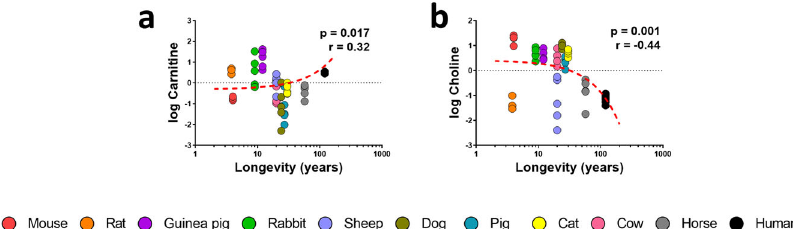
Fig. 6 Methionine-derived lipid intermediates and its correlation with animal longevity. Individual plasma concentration of lipid intermediates carnitine ( a ) and choline ( b ). Pearson correlation between plasma metabolites and animal longevity was performed. Minimum signi fi cation level was set at p < 0.05. All metabolites were log-transformed in order to accomplish the assumptions of normality. Data values are obtained from four (mice and cows), fi ve (rats, rabbits, guinea pigs, sheep, dogs, pigs, cats and horses) or six (humans) specimens.